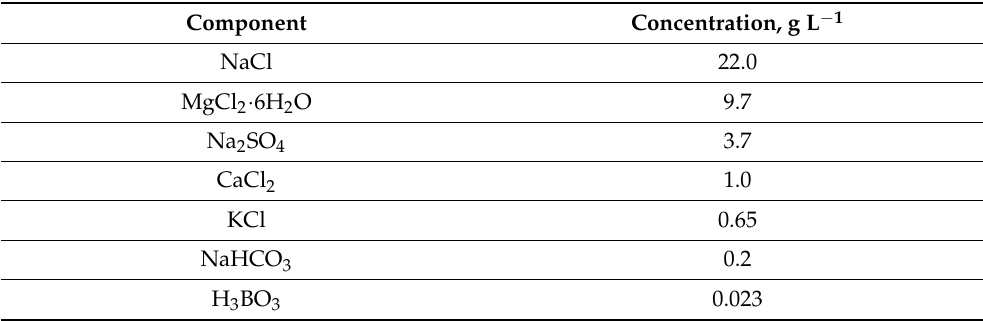
Table A3. Composition of synthetic sea water used as a control solutions in A. fischeri toxicity